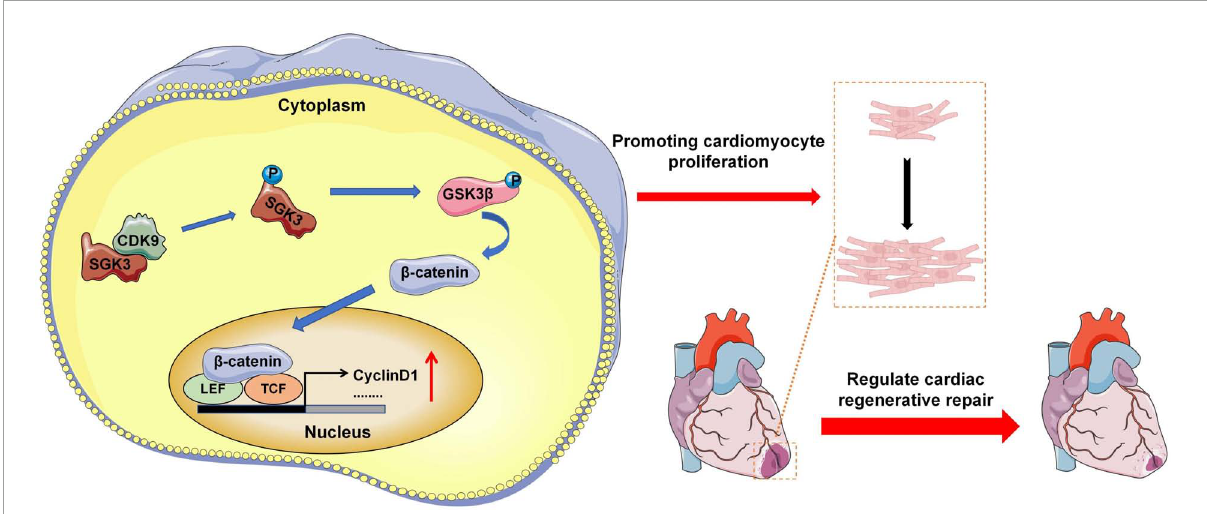
FIGURE8 Research pattern diagram. Model depicting CDK9 binds to SGK3 and activates SGK3 and its downstream GSK-3 β / β -catenin/cyclin D1 pathways to regulate the CM cycle activity, promoting CM proliferation and myocardial regeneration (CMs indicate